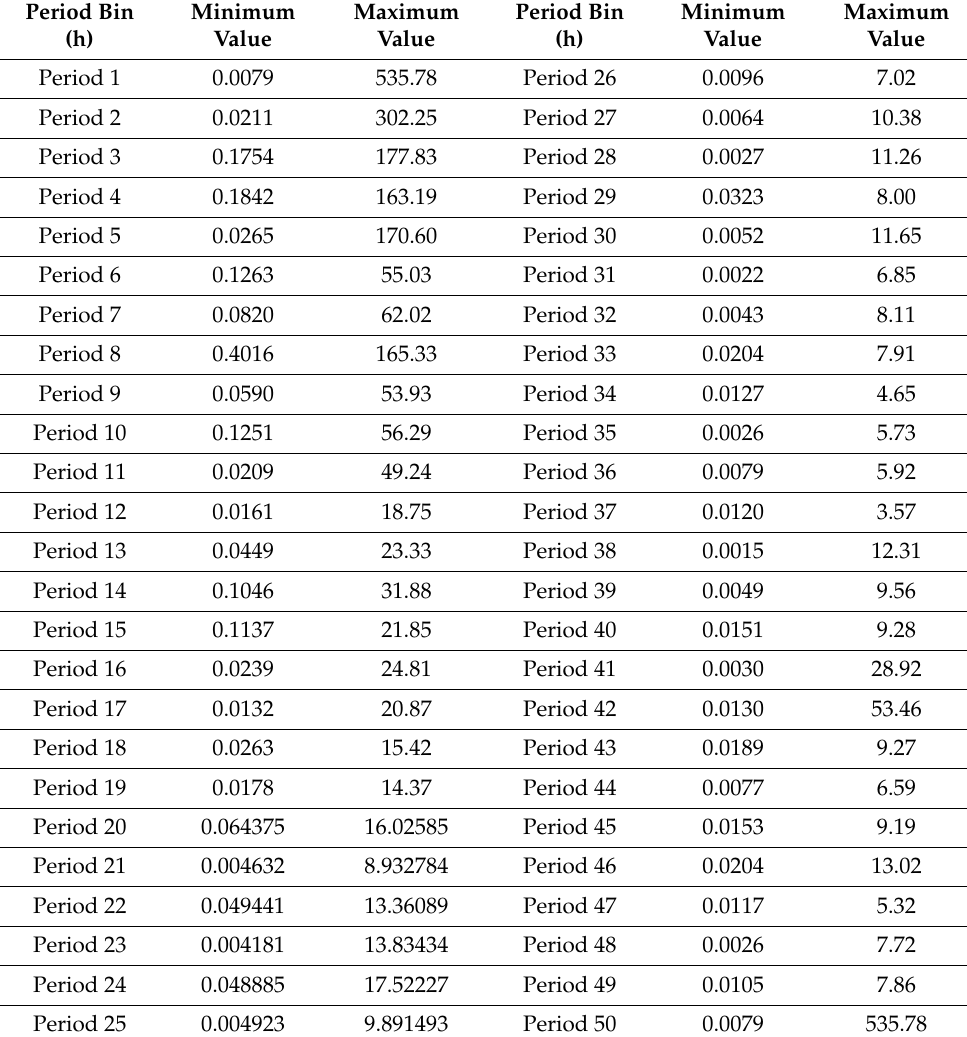
Table A1. Ranges of the first 50 h of the power spectrum